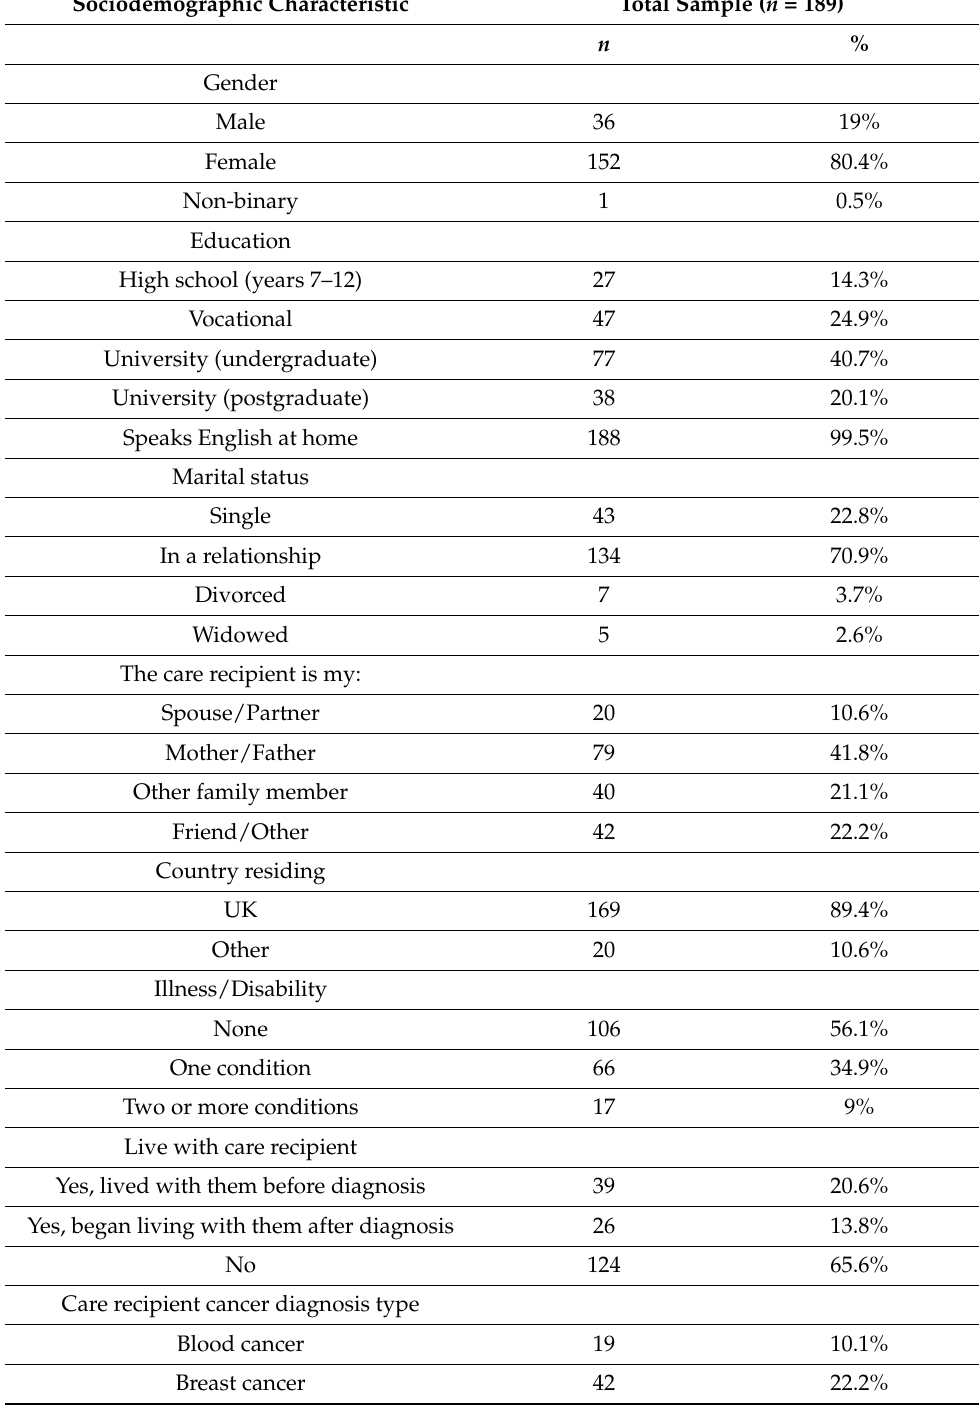
Table 1. Sociodemographic details of 189